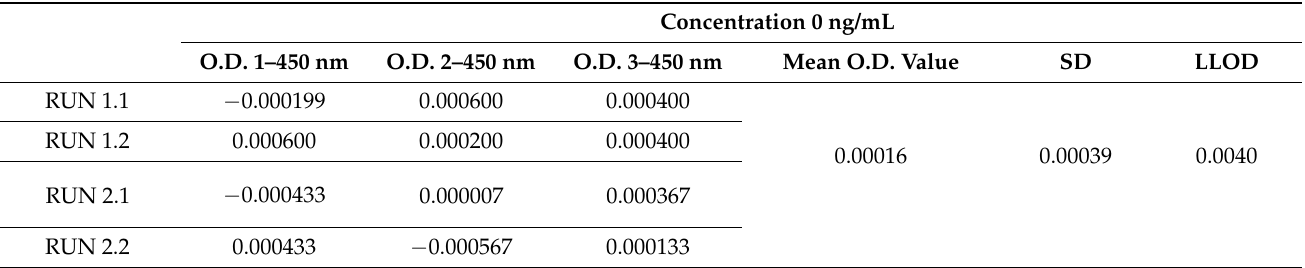
Table 2. Evaluation of the Lower Limit of